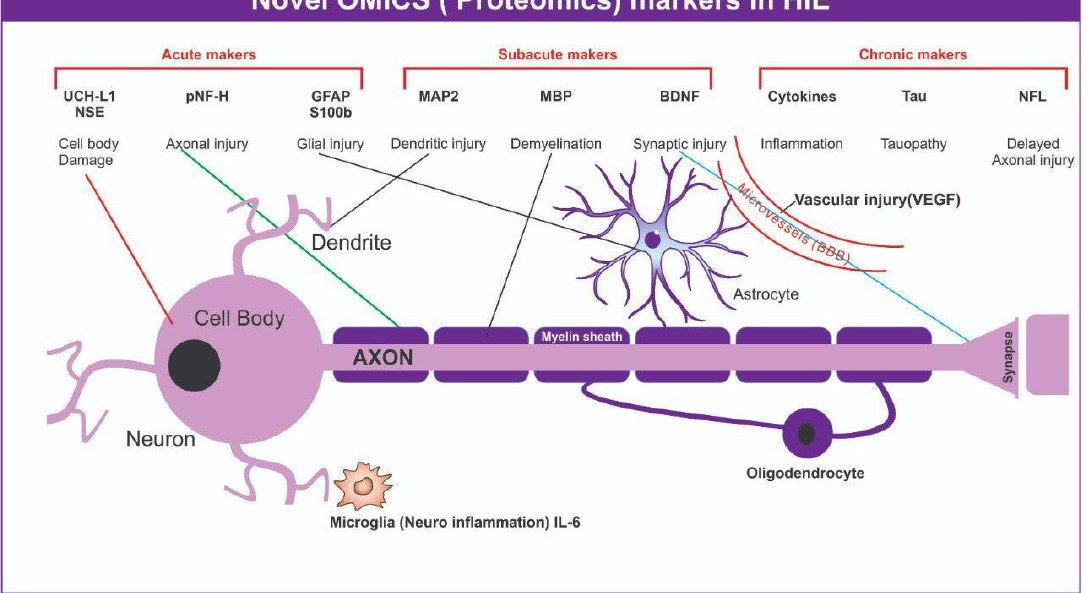
Figure 3. Proteomics markers in neonatal HIE.